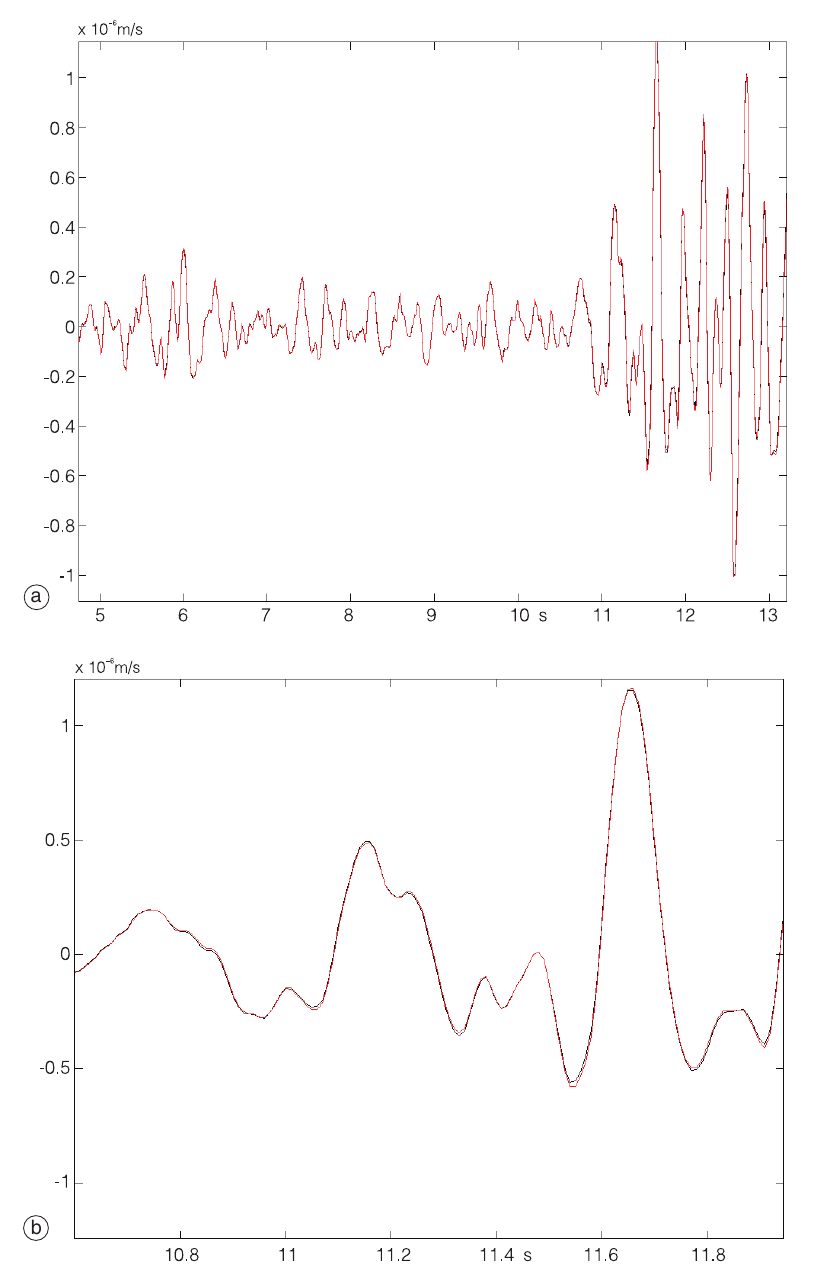
Fig. 8a,b. Example of recording of the displacement velocities by two anti-parallel sensors (Ojcow Observatory, record of a Silesian event at distance about 60 km; 11 July 2001, 18 h 50 min; magnitude about 1.5); parts (a) and (b) are in different time